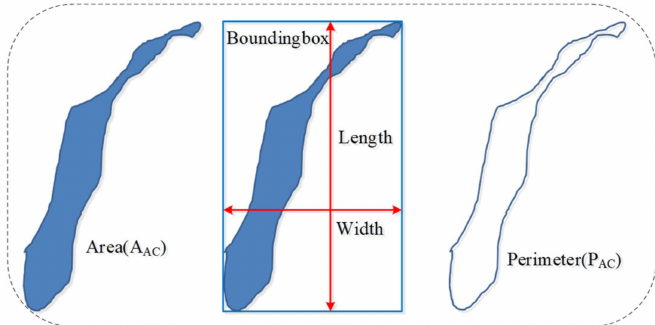
Figure 3. Hole or crack diagram.